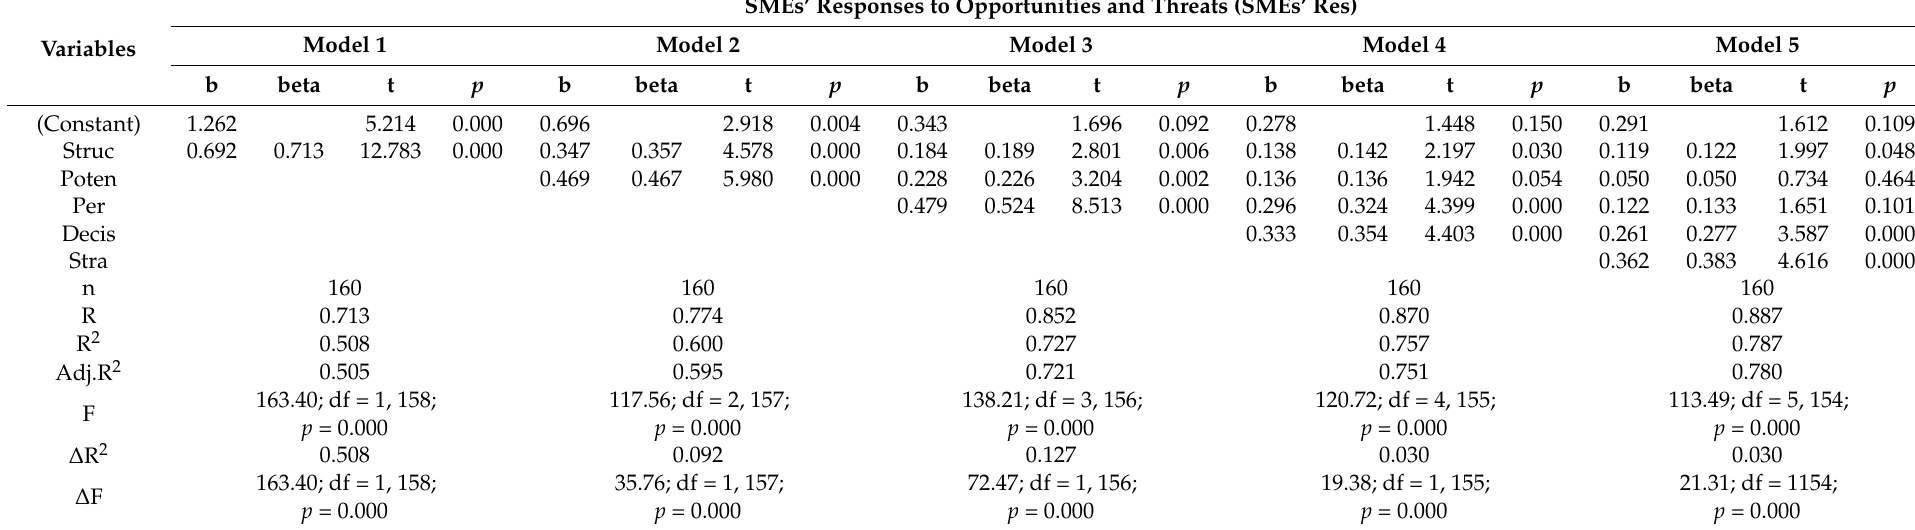
Table 4. Multiple regression